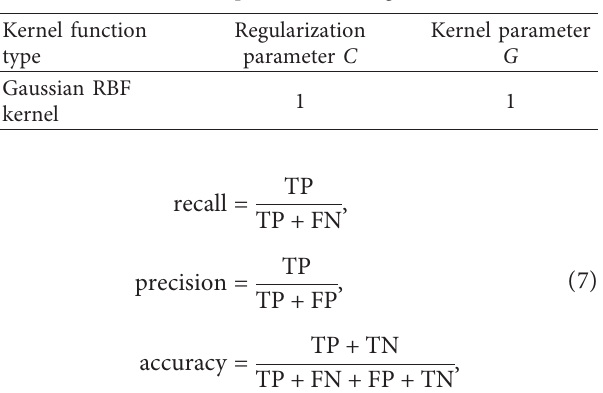
Table 3: The parameter settings of SVM. Table 4: Meaning of four